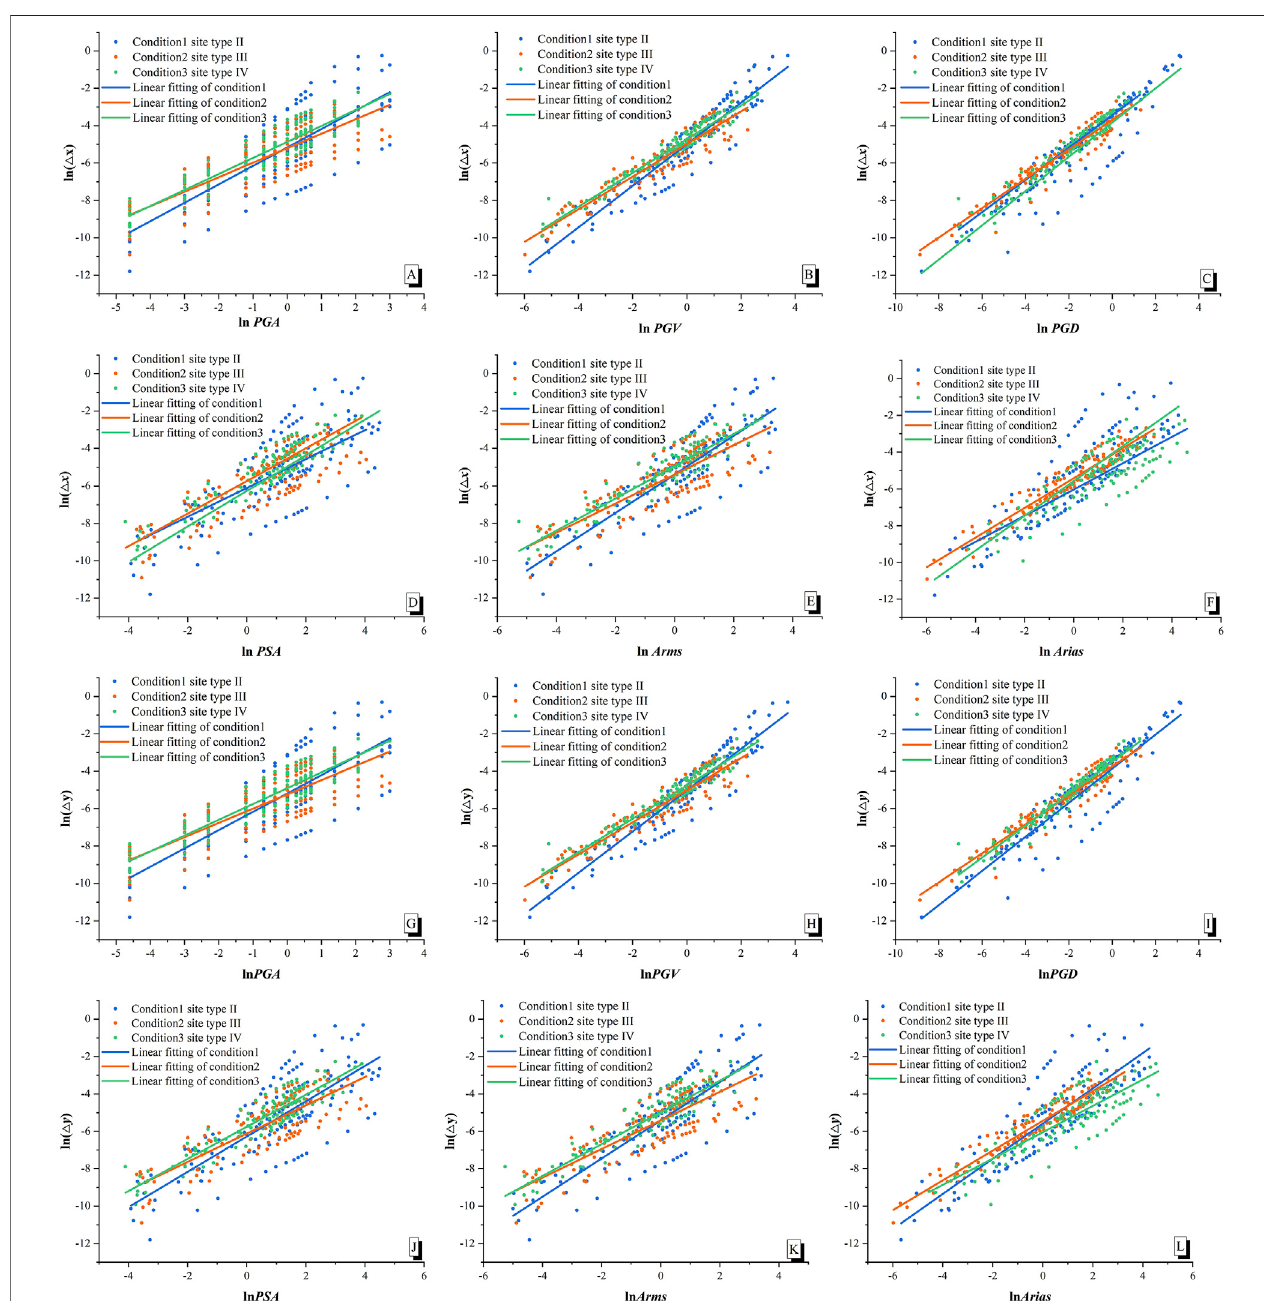
FIGURE 7 | (A – F) Thestatisticsfortheseismicdemandmodeloftheamountoftheringjointopeningand (G – L) thestatisticsfortheseismicdemandmodelofthedislocation.